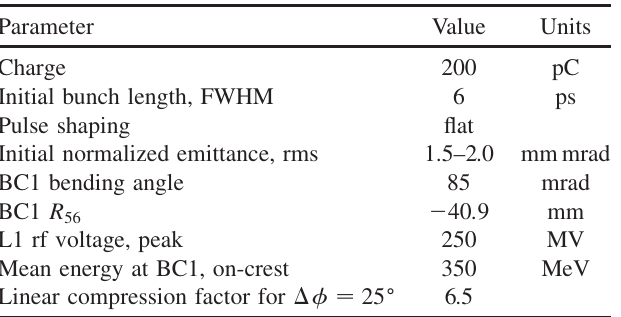
TABLE I. Fermi electron beam and machine parameters for one-stage compression in